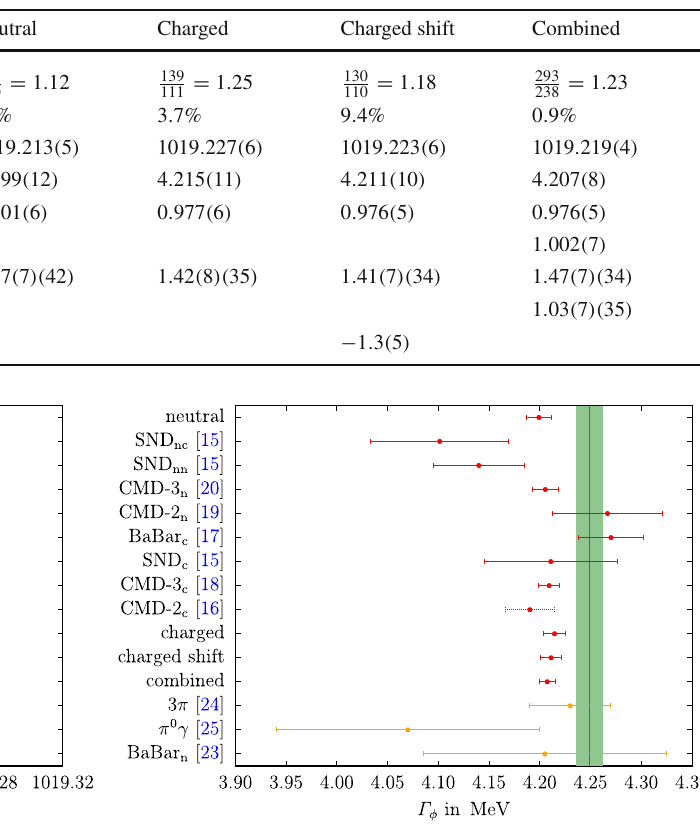
Fig. 3 Results of the individual and the combined neutral and charged data sets for M φ (left) and Γ φ (right) in red. “combined” refers to the scenario in which the φ resonance parameters and all couplings are fit simultaneously, corresponding to “combined n ” and “combined c ” in Fig. 2, otherwise, the notation is as in that figure. The green band